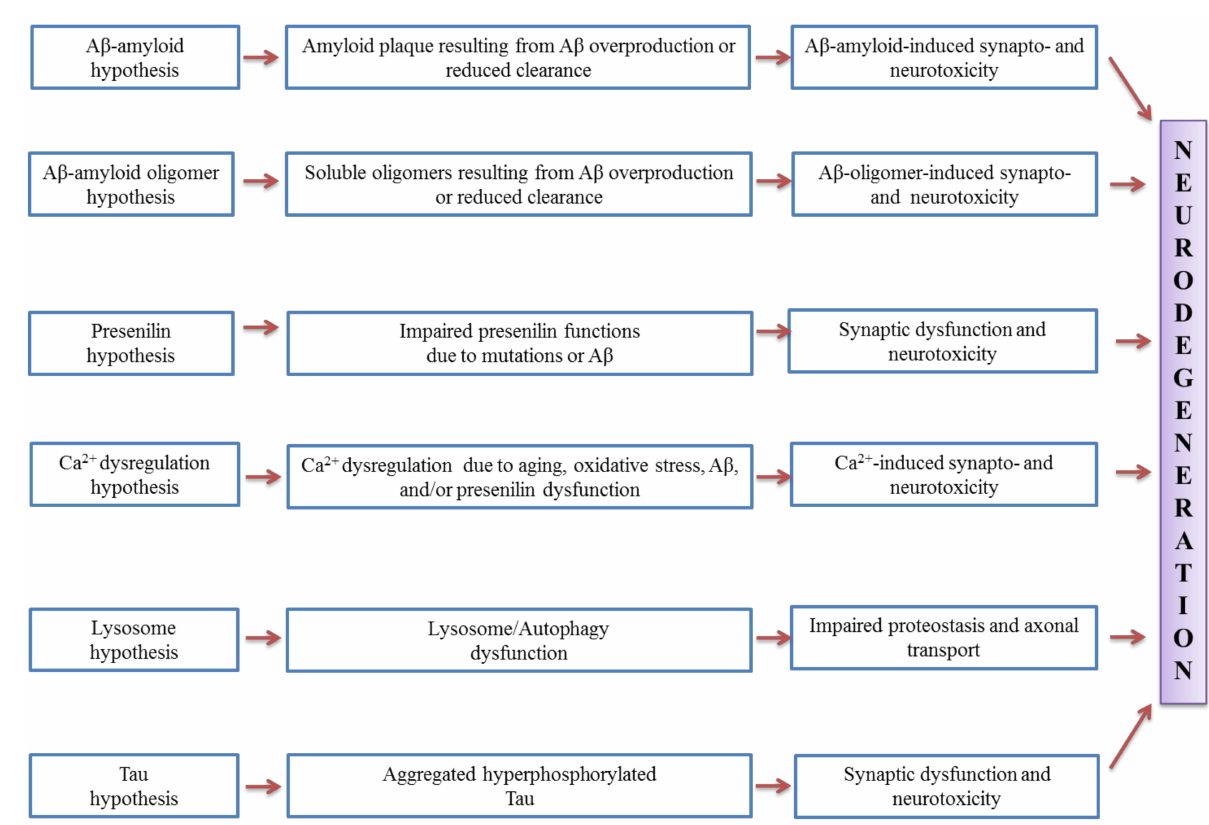
Figure 1. Pathogenic hypotheses for synaptic and neuronal toxicity in Alzheimer’s disease (adapted from [39]).